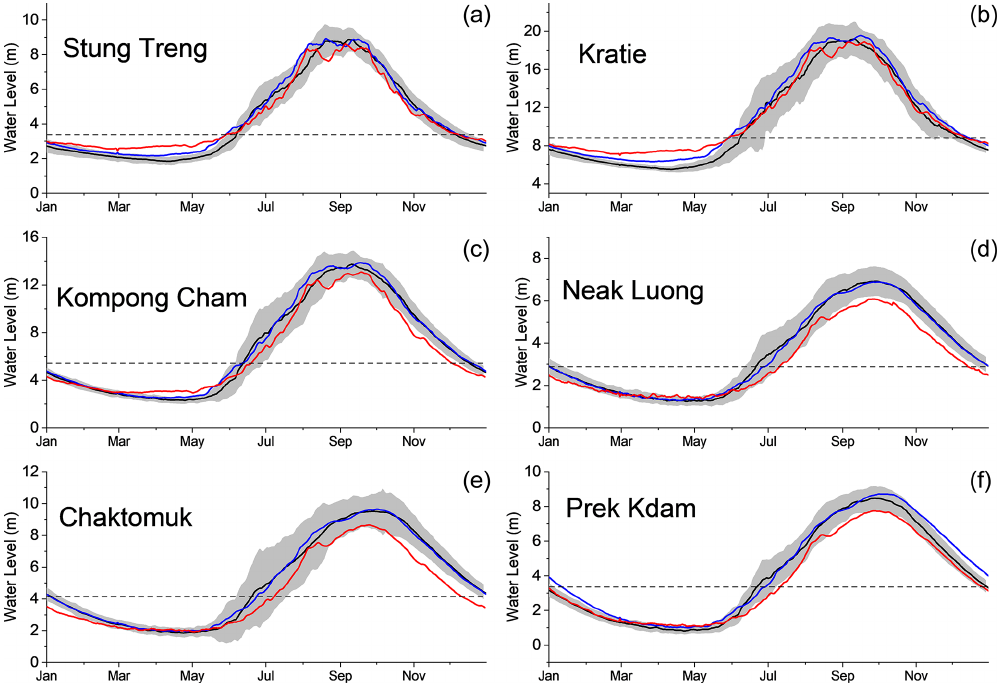
Figure 4. Variation of mean water levels at various stations within the Cambodian floodplains over time. Dotted horizontal line: flood threshold; black curve: water levels from 1960–1991; blue curve: water levels from 1992–2009; red curve: water levels from 2010–2019. Shaded region represents 1 standard error of mean water levels from 1960–1991.